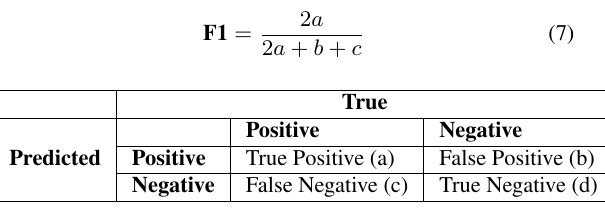
Figure 5. Classification maps for the study area F1-score is defined in equation (7) as following.